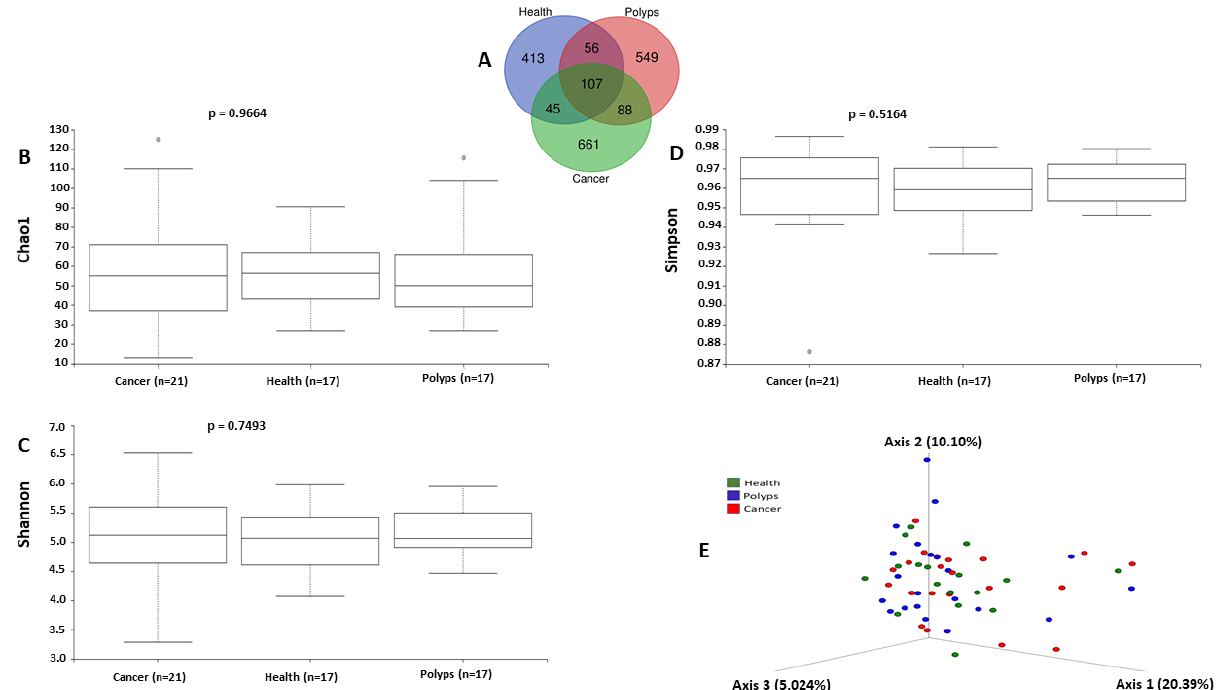
Figure 1. Venn diagram ( A ) representing the shared and unique ASVs among the three experimental groups. Boxplots showing alpha diversity (( B ) Chao1, ( C ) Shannon, and ( D ) Simpson) among the experimental groups. PCoA ( E ) showing the bacterial beta diversity among the experimental groups based on weighted UniFrac distances.